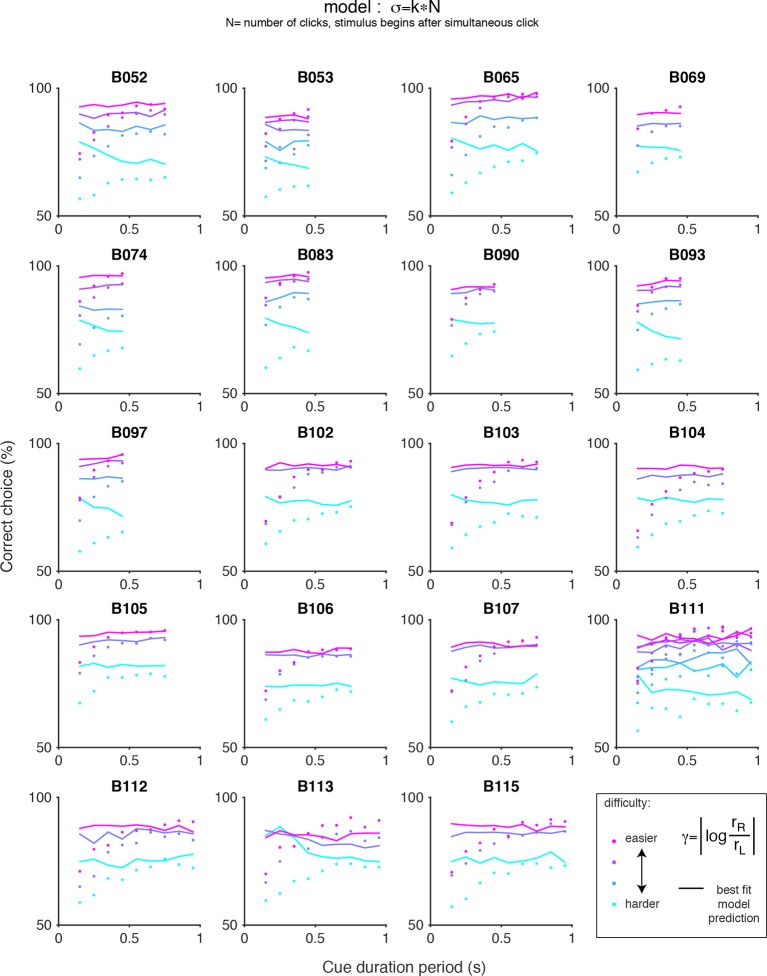
Chronometric plots for the auditory (clicks) data and predictions of scalar variability.Each panel shows the performance of an individual rat on the auditory accumulation task as a function of the duration of the cue period. Colored dots indicate the data and colored lines indicate the prediction of pure scalar variability: σ = kN, where N is the number of clicks after the simultaneous click. Color indicates trial difficulty, parameterized by γ, the log of the ratio of the rates of the clicks on each side. Across all animals, performance increases as a function of cue duration for a fixed γ (colored dots), however, pure scalar variability predicts flat psychometric function (colored lines).